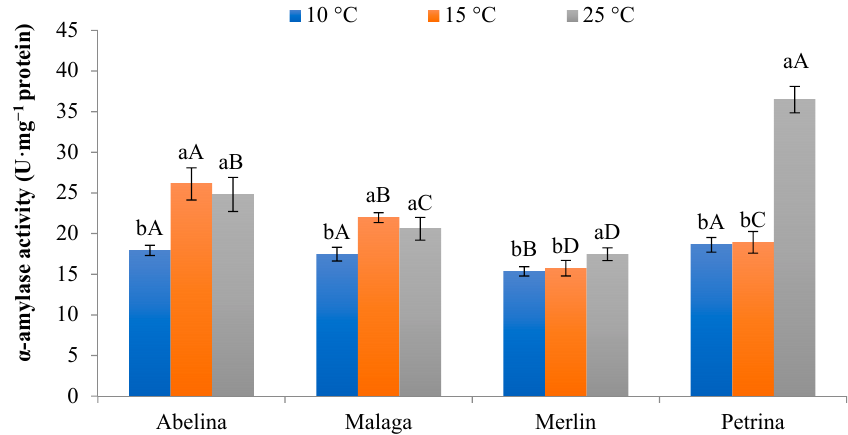
Figure 3. Activity of α -amylase (U mg − 1 protein) in the seeds of four soybean cultivars germinated at different temperatures. Values represent means ( n = 3) ± SE. The values for each cultivar followed by the same lowercase letter do not differ significantly, while means for the same temperature marked with the same uppercase letter do not differ significantly according to Duncan’s multiple range test ( p < 0.05).